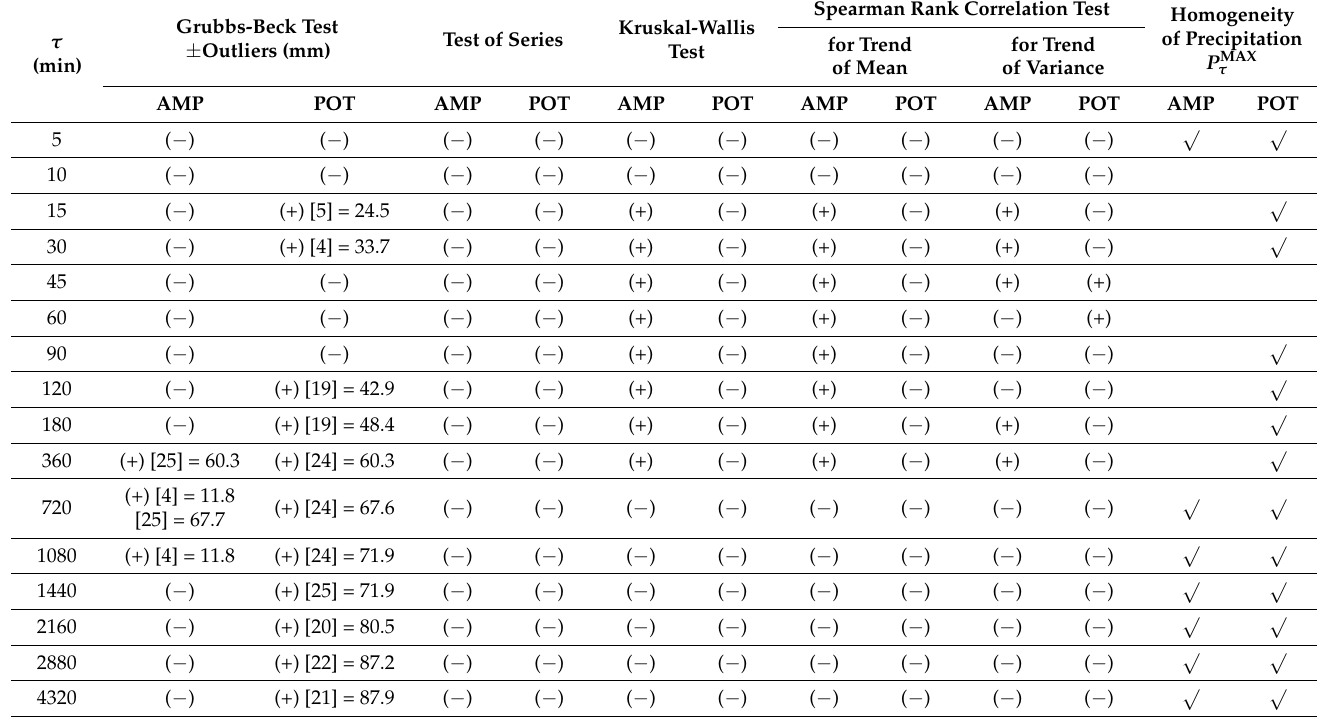
Table 2. Results of nonhomogeneity analysis of AMP and POT precipitation series from Chojnice meteorological station; ( − )/(+) denotes, respectively, negative and positive test results;